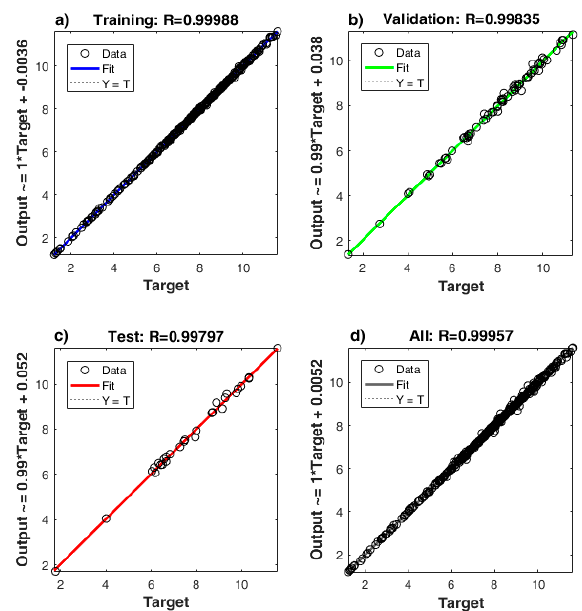
Figure 4. Plot of ANN calculated log 10 (harmonic yield) against the values obtained with the complete 3D model for the following data subsets: ( a ) training, ( b ) validation, ( c ) testing and ( d ) overall data. Table.1. The mean and maximum values of the relative error.